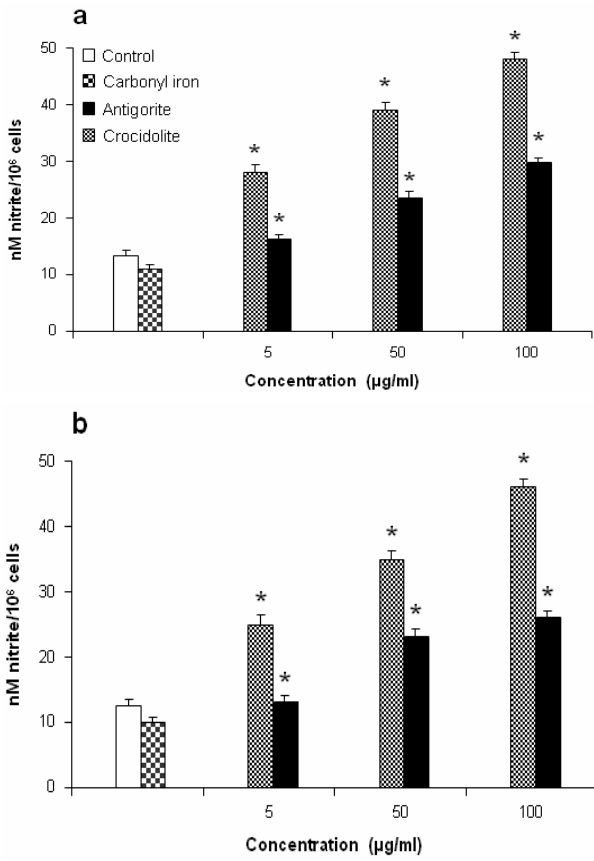
Figure 8: Nitrite release from MeT-5A (a) and J774 (b) cells quantified by colorimetric assay in the culture media. The values, expressed as nM nitrite per 10 6 cells, are the mean ± SEM of three experiments performed in triplicate. Antigirite caused significant (*, P<0.01) release of nitrite as compared to untreated control experiments.